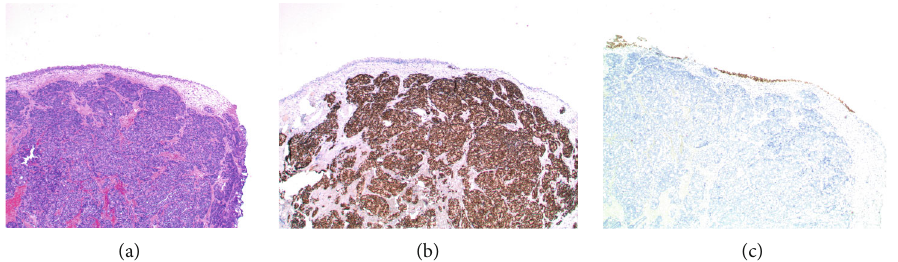
Figure 1: Negative GATA3 and positive NKX3.1 staining con fi rms prostatic adenocarcinoma. Low power view of the bladder tumor in (a) shows a normal urothelial mucosa and tumor beneath the urothelium, involving the submucosa. Underlying invasion of the muscularis propria was also present. (b) Strong di ff use nuclear staining with the immunohistochemical stain NKX3.1 was seen. Note the surface urothelium is negative. (c) The tumor cells are negative for the immunohistochemical stain GATA3, while the surface benign urothelium shows positive nuclear staining.